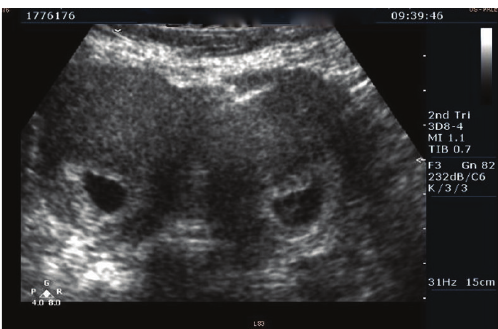
Figure 2: Two gestational sacs in coronal and sagittal view of 3D ultrasound.